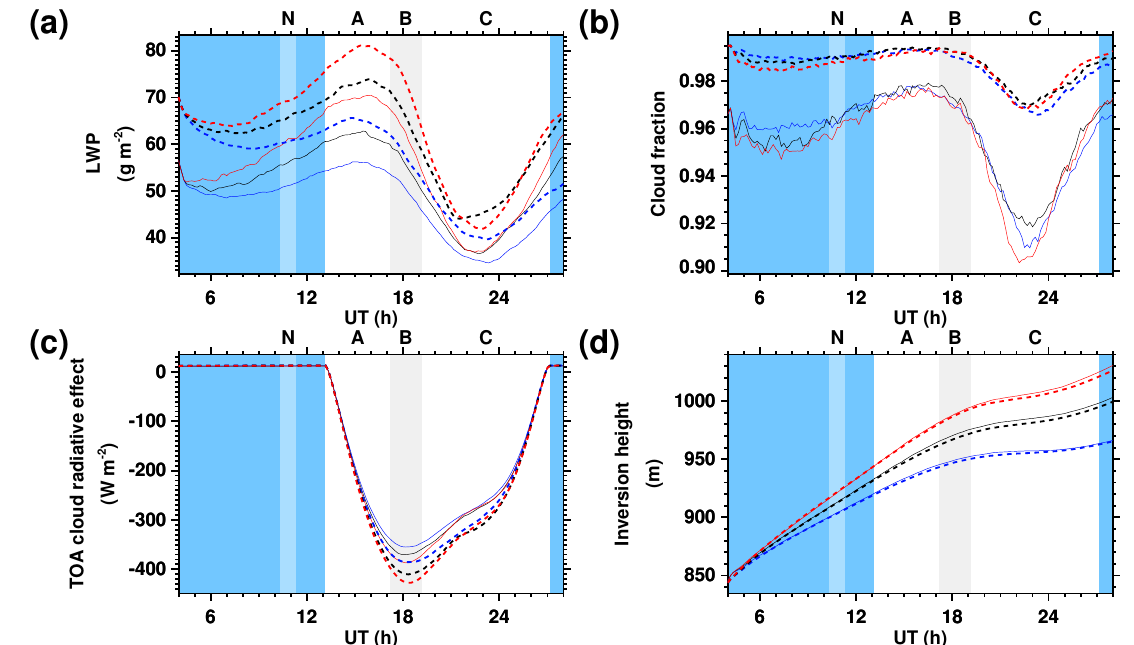
Figure C1. Effect of resolution. Solid curves denote simulations with the base resolution, dashed curves simulations with double resolution in each dimension (Table 2). M − (blue solid), M 0 (black solid), M + (red solid); M − dashed).